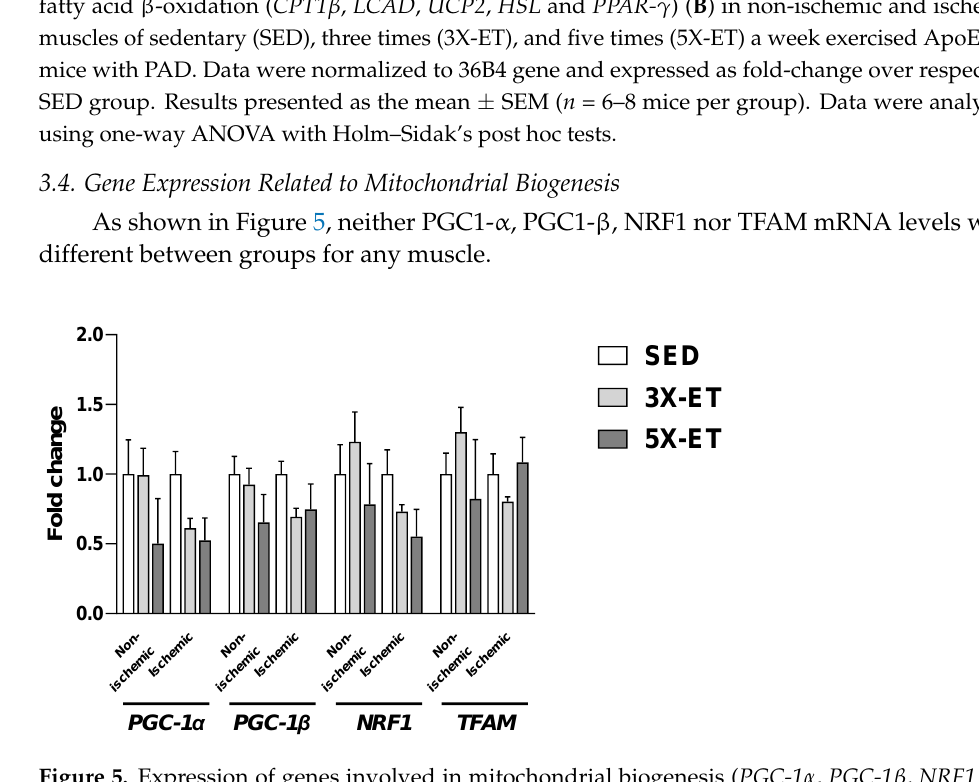
Figure 5. Expression of genes involved in mitochondrial biogenesis ( PGC-1 α , PGC-1 β , NRF1 and TFAM ) in non-ischemic and ischemic muscles of sedentary (SED), three times (3X-ET), and five times (5X-ET) a week exercised ApoE − / − mice with PAD. Data were normalized to 36B4 gene and expressed as fold-change over respective SED group. Results presented as the mean ± SEM ( n = 6–8 mice per group). Data were analyzed using one-way ANOVA with Holm–Sidak’s post hoc